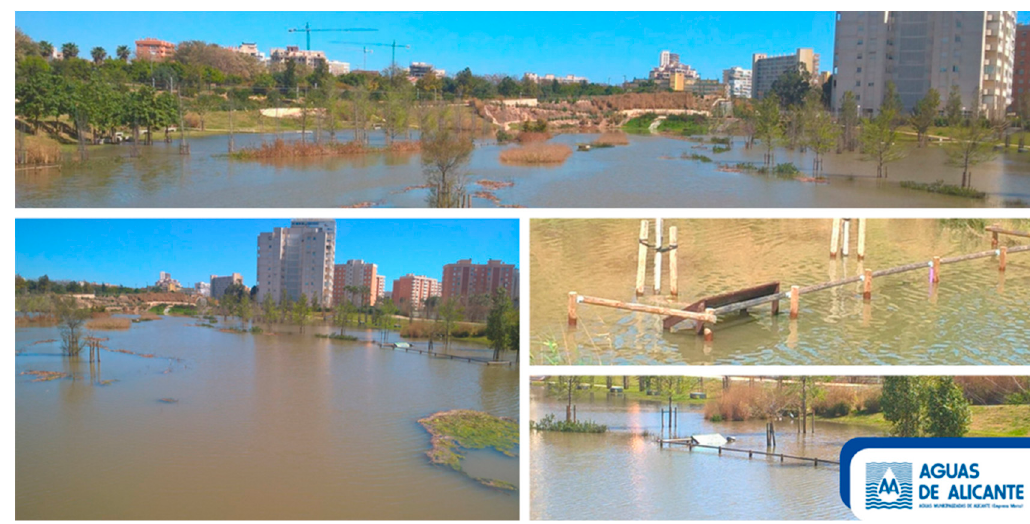
Figure 7. La Marjal Floodplain Park flooded after the rain episodes of 21 August 2019. Source: [42].